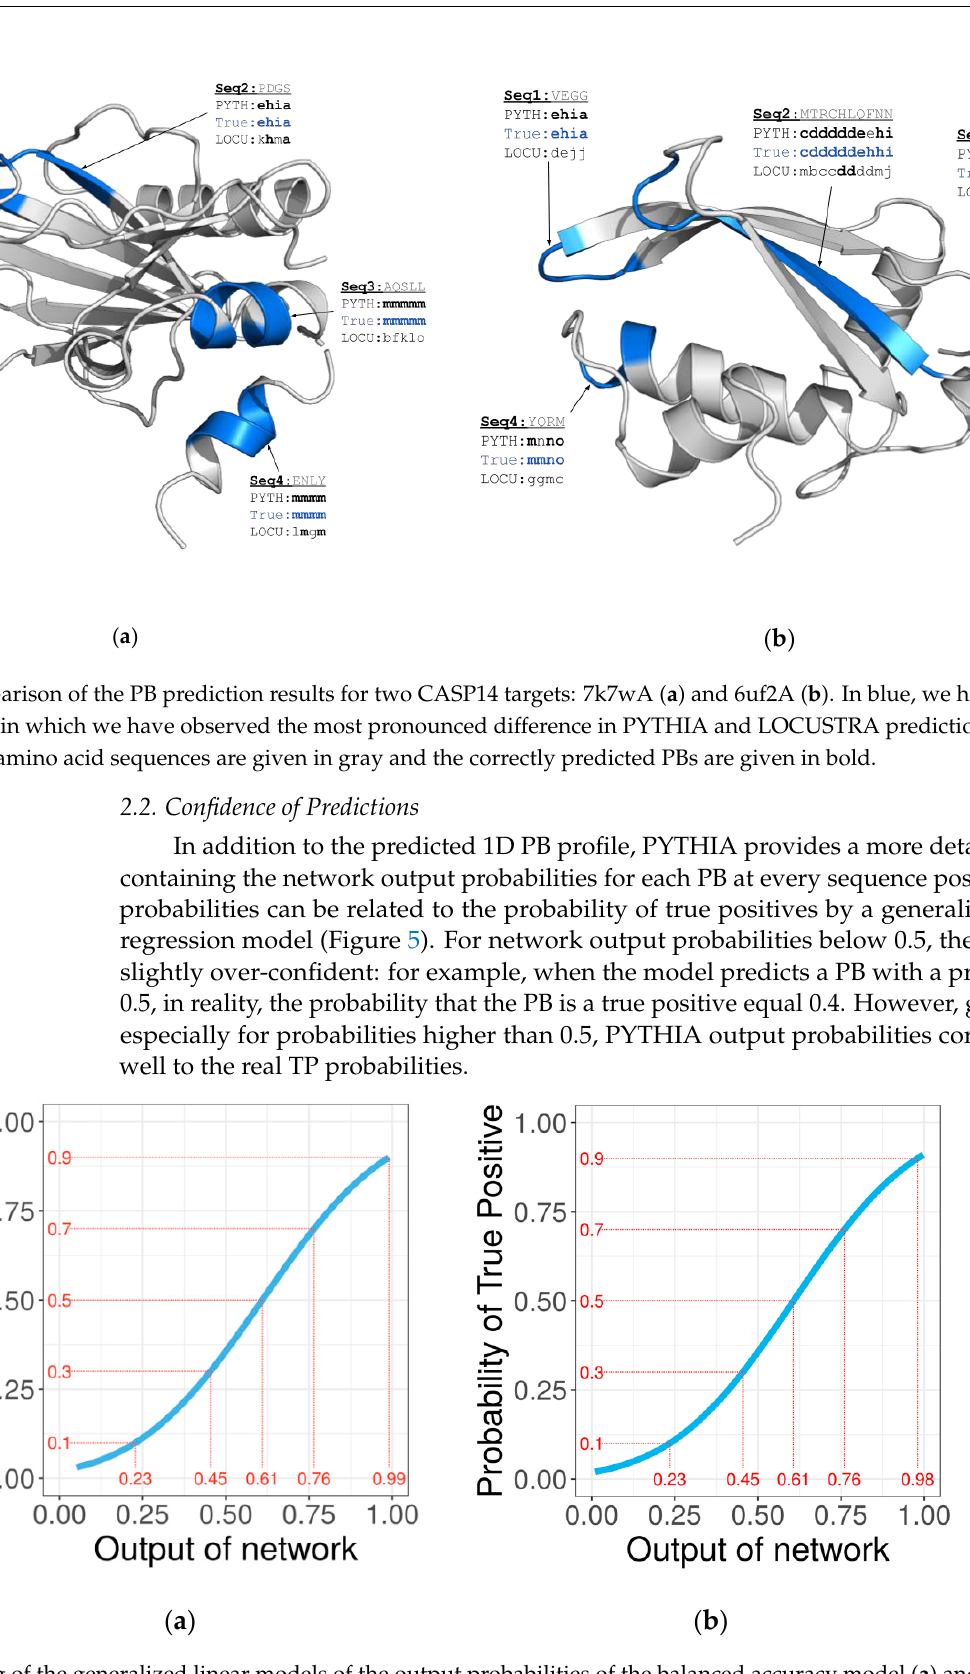
Figure 5. Fitting of the generalized linear models of the output probabilities of the balanced accuracy model ( a ) and global accuracy model ( b ) against the probability of true positives.